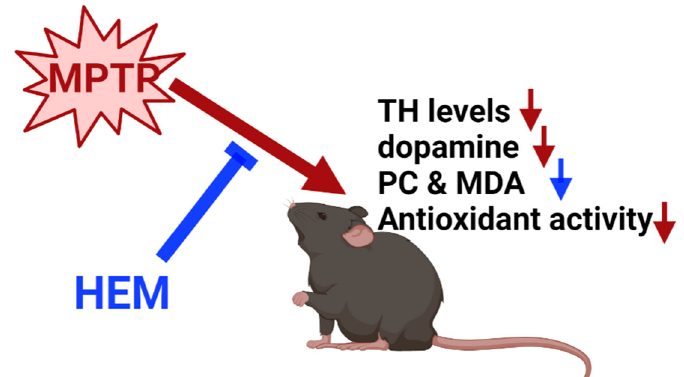
Figure 9. A schematic diagram of HEM preventing MPTP toxicity. Deep red represents the results of MPTP treatment; blue represents the results of HEM treatment. MDA, malondialdehyde; PC, protein carbonyl; TH, tyrosine hydroxylase. Deep red arrows represent the results of MPTP treatment; blue arrows represent the results of HEM